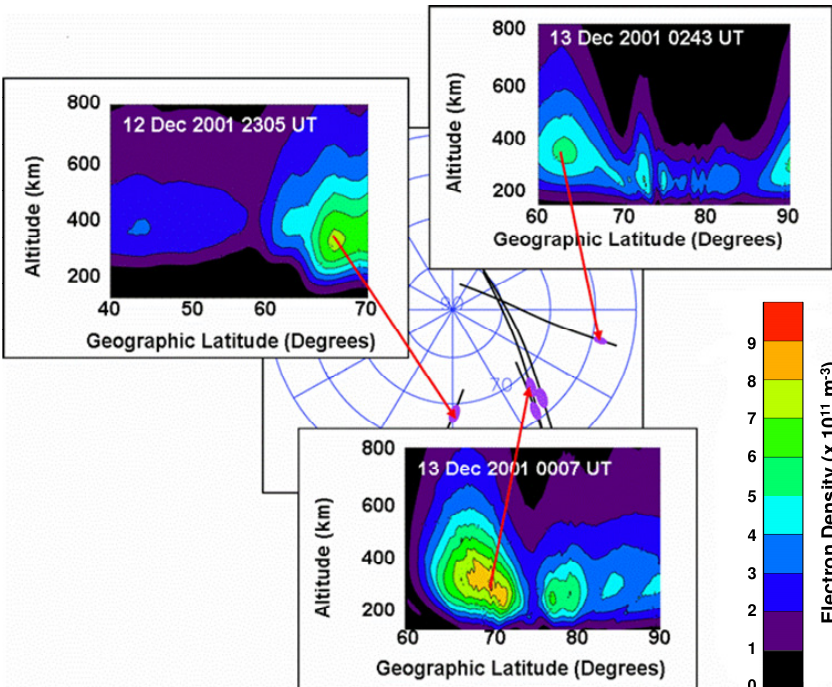
Fig. 2. Three sample tomography reconstructions for 23:05UT (UK), 00:07UT (Scandinavia) and 02:43UT (Scandinavia) on the evening of 12–13 December 2001. The locations of the maximum electron density of the prominent enhancement in the three reconstructions, and two other reconstructions (not shown), are indicated in the centre panel by the purple dots on a MLAT versus MLT polar plot. Magnetic local midnight is at the bottom of the circles, with 06:00UT on the right-hand-side.